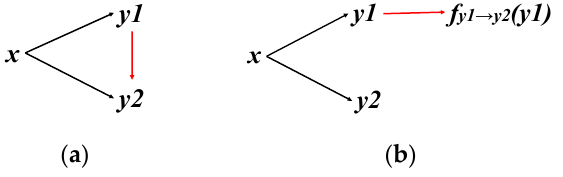
Figure 2. Illustration of different consistency constraints. ( a ) The elementary consistency constraint (Equation (2)); ( b ) the relaxed consistency constraint (Equation (6)).